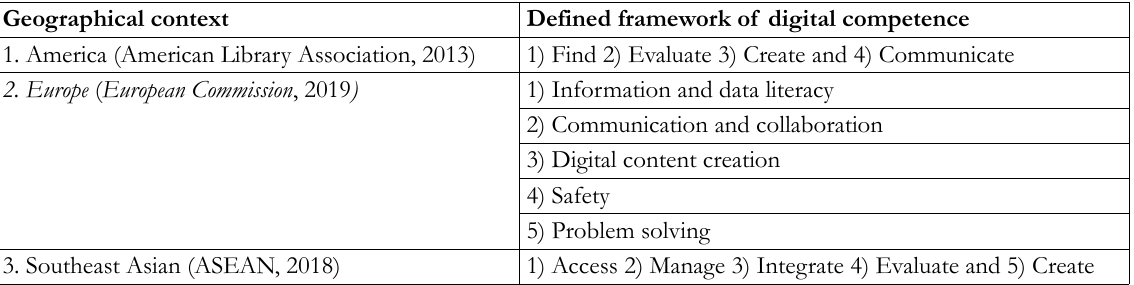
Table 1. Geographic-based formulations of digital competency